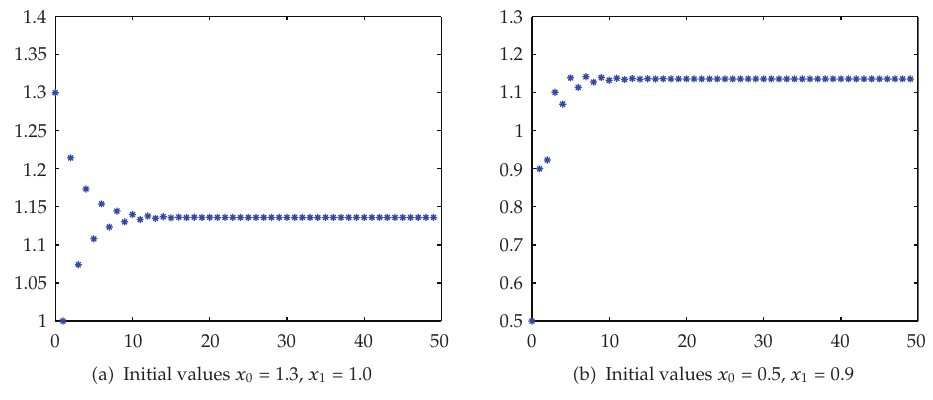
Figure 4: r (cid:5) 2, q (cid:5) 1; x ∗ (cid:5) (cid:7)